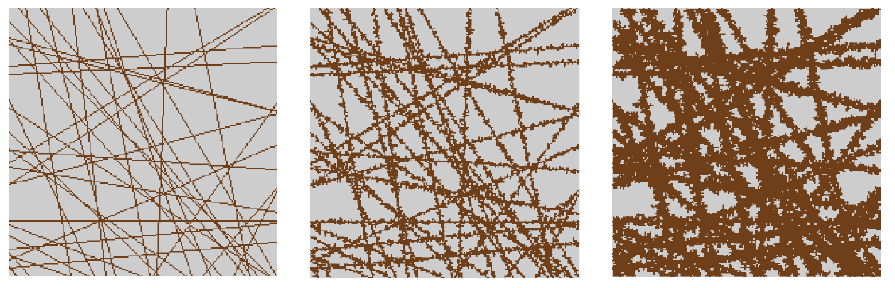
Figure 9. Three time slices from a CellLab-CTS model of bedrock weathering along fracture planes. Light-colored cells are unweathered mineral grains; dark-colored cells are grains that have been chemically altered to form saprolite (rock material that has been weathered but not displaced). Left to right: time 0, time 10, and time 30. Here the time is normalized by initial fracture width and weathering rate; one time unit represents the average time to weather fresh rock to a depth of one initial fracture width. For example, if fracture width (cell size) were 1cm and weathering rate 10 − 5 myr − 1 , then one time unit = 1000 years.